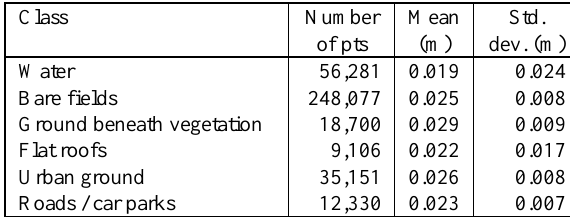
Table 4. Height point precision by class.